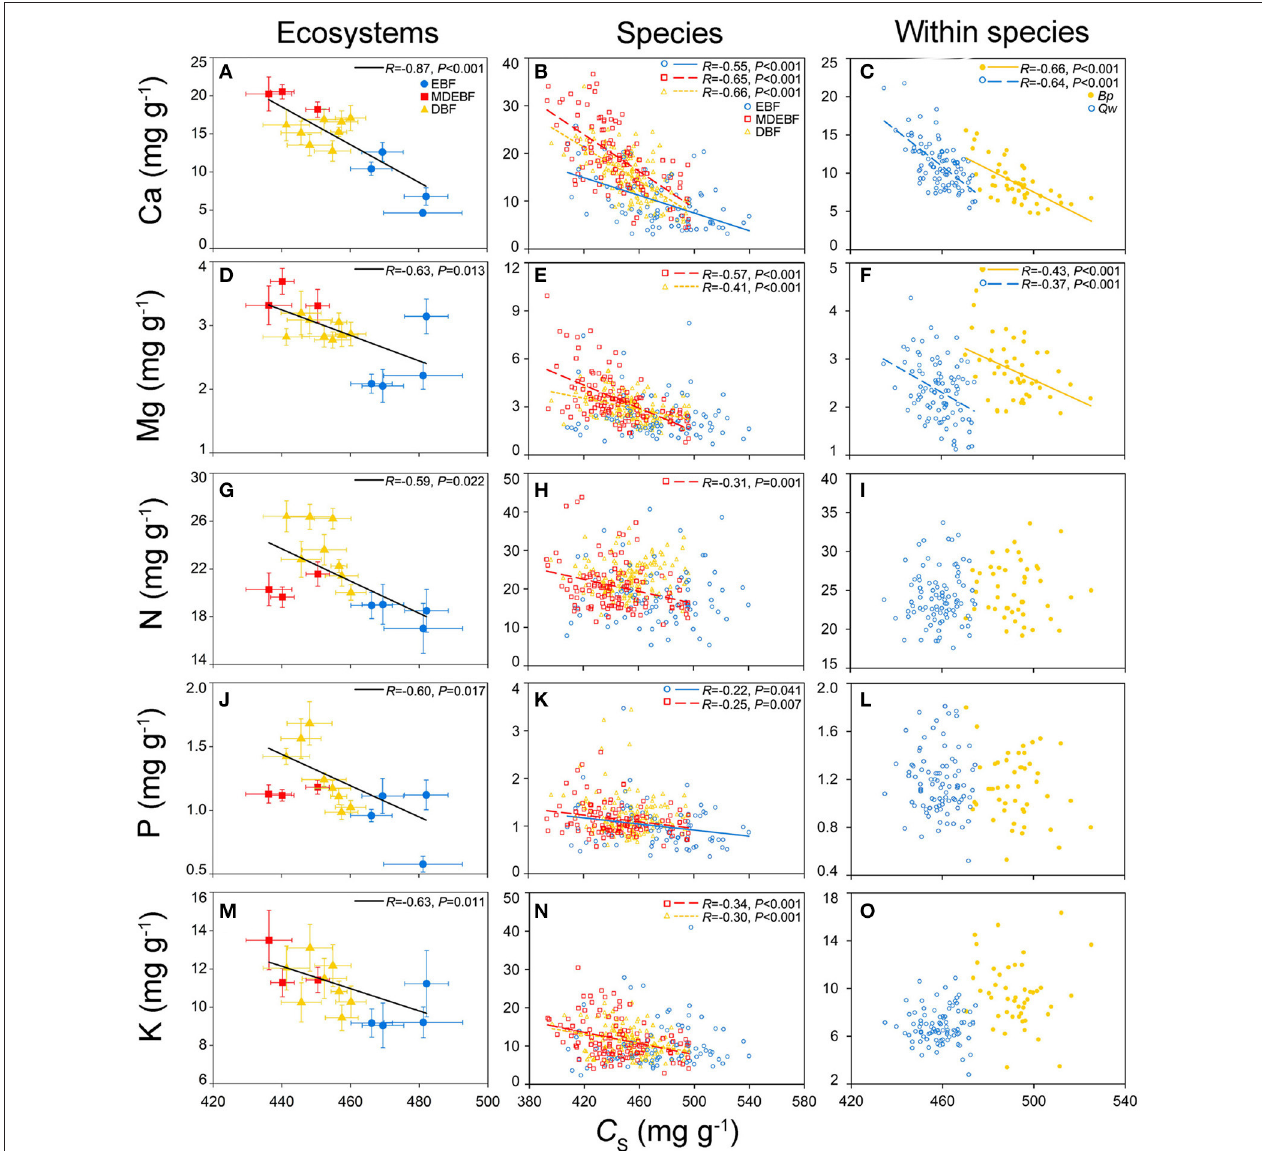
FIGURE 1 | Relationships between leaf protein-free carbon (C S ) and macronutrient concentrations at the ecosystem, species, and within species scales. Filled circles/squares/triangles represent average value with the standard division of leaf C S and macronutrients from the evergreen broad-leaved forest (EBF), mixed deciduous and evergreen broad-leaved forests (MDEBF), deciduous broad-leaved forest (DBF), and continuous lines represent regressions between leaf C S and macronutrients at ecosystem scale ( P ≤ 0.05) (A,D,G,J,M) , error bars represent standard errors of the mean. Open circles/squares/triangles and continuous/dashed/dotted lines inspecies groups represent samples from EBF/MDEBF/DBF ( P ≤ 0.05) (B,E,H,K,N) . Filled/open circles and continuous/dashed lines at within species scale represent samples of Quercus wutaishanica (Qw), Betula platyphylla (Bp) (C,F,I,L,O) . R is Pearson’s correlation